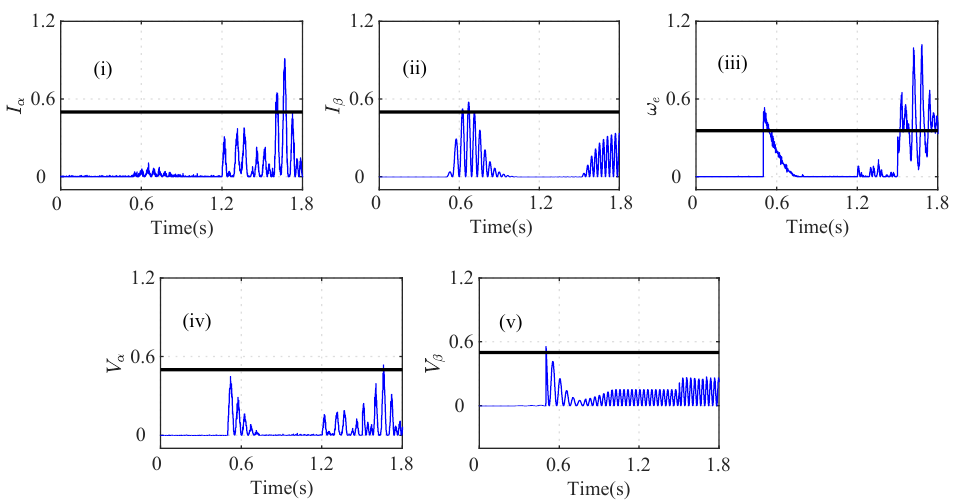
Figure 16. A c I -based analysis for current ((i) I α , (ii) I β ), speed ((iii) ω e ), and voltage sensors’ ((iv) V α , (v) V β ) residuals during the incipient i α fault at t = 1.25 s and intermittent W ω fault scenario at t = 0.5 s and t = 1.50 s,